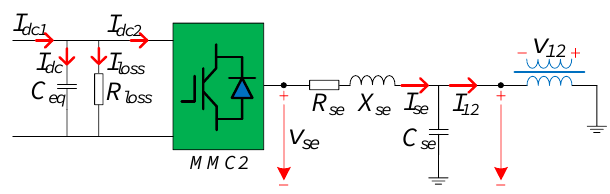
Figure 15. The detailed structural diagram of the series converter.